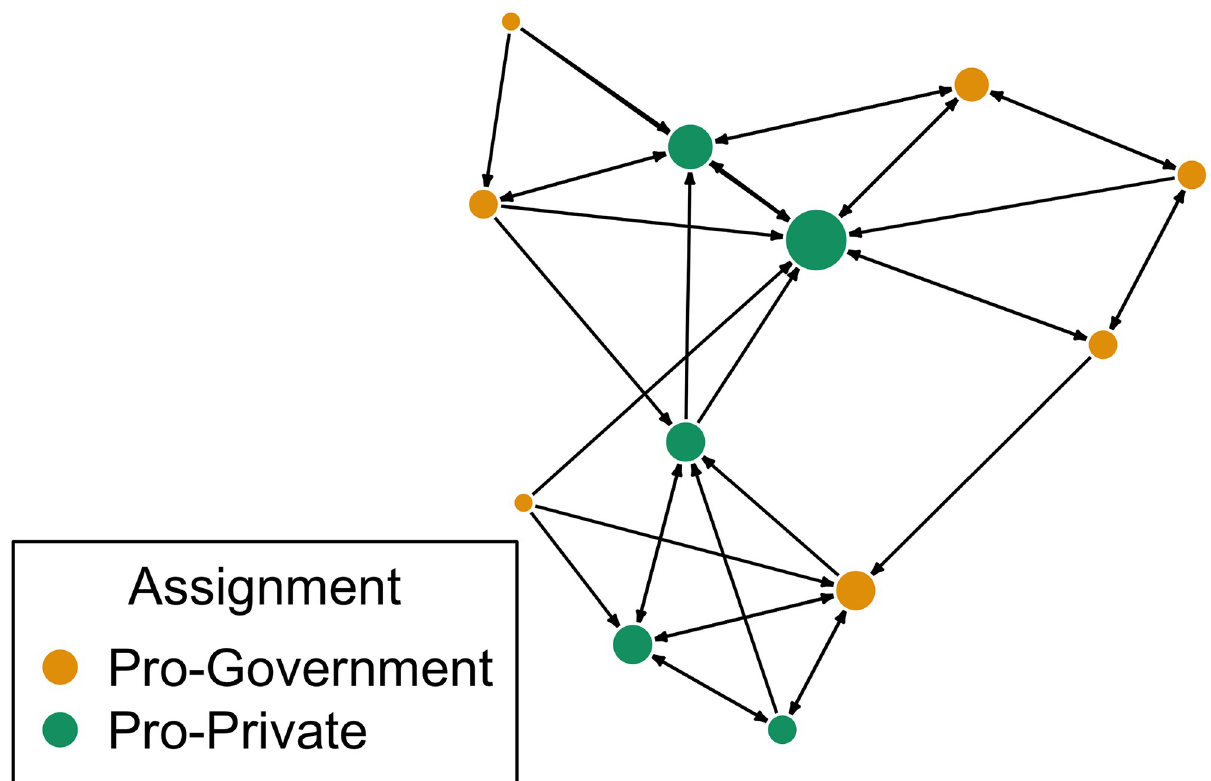
Fig 3. An example of one of the student organizations in our